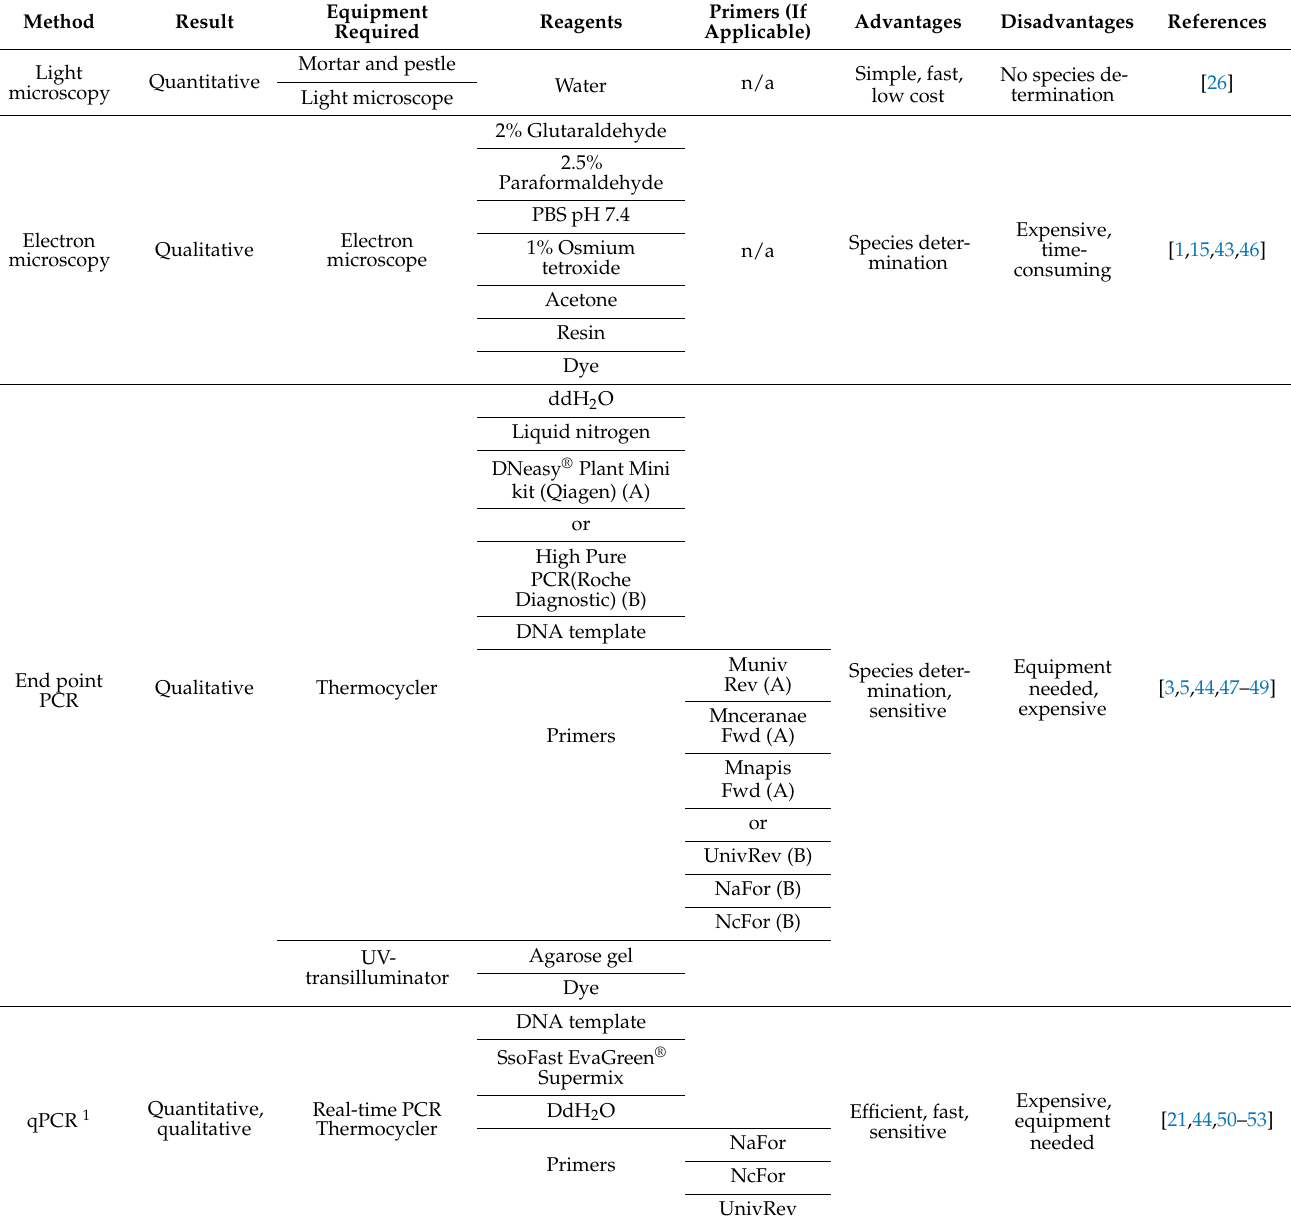
Table 2. Methods used in Nosema spp. diagnostics with their key components, advantages, and